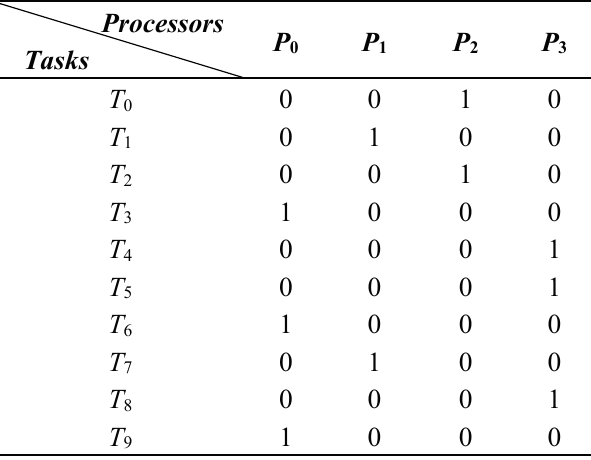
Table 2. Scheduling matrix X 10×4